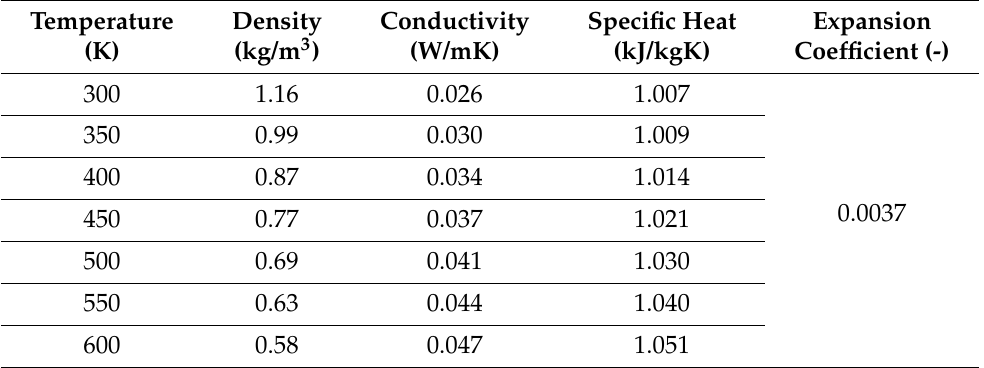
Table 1. Properties of air (Model I) modelled based on temperature as a continuum between the vessel and the pan